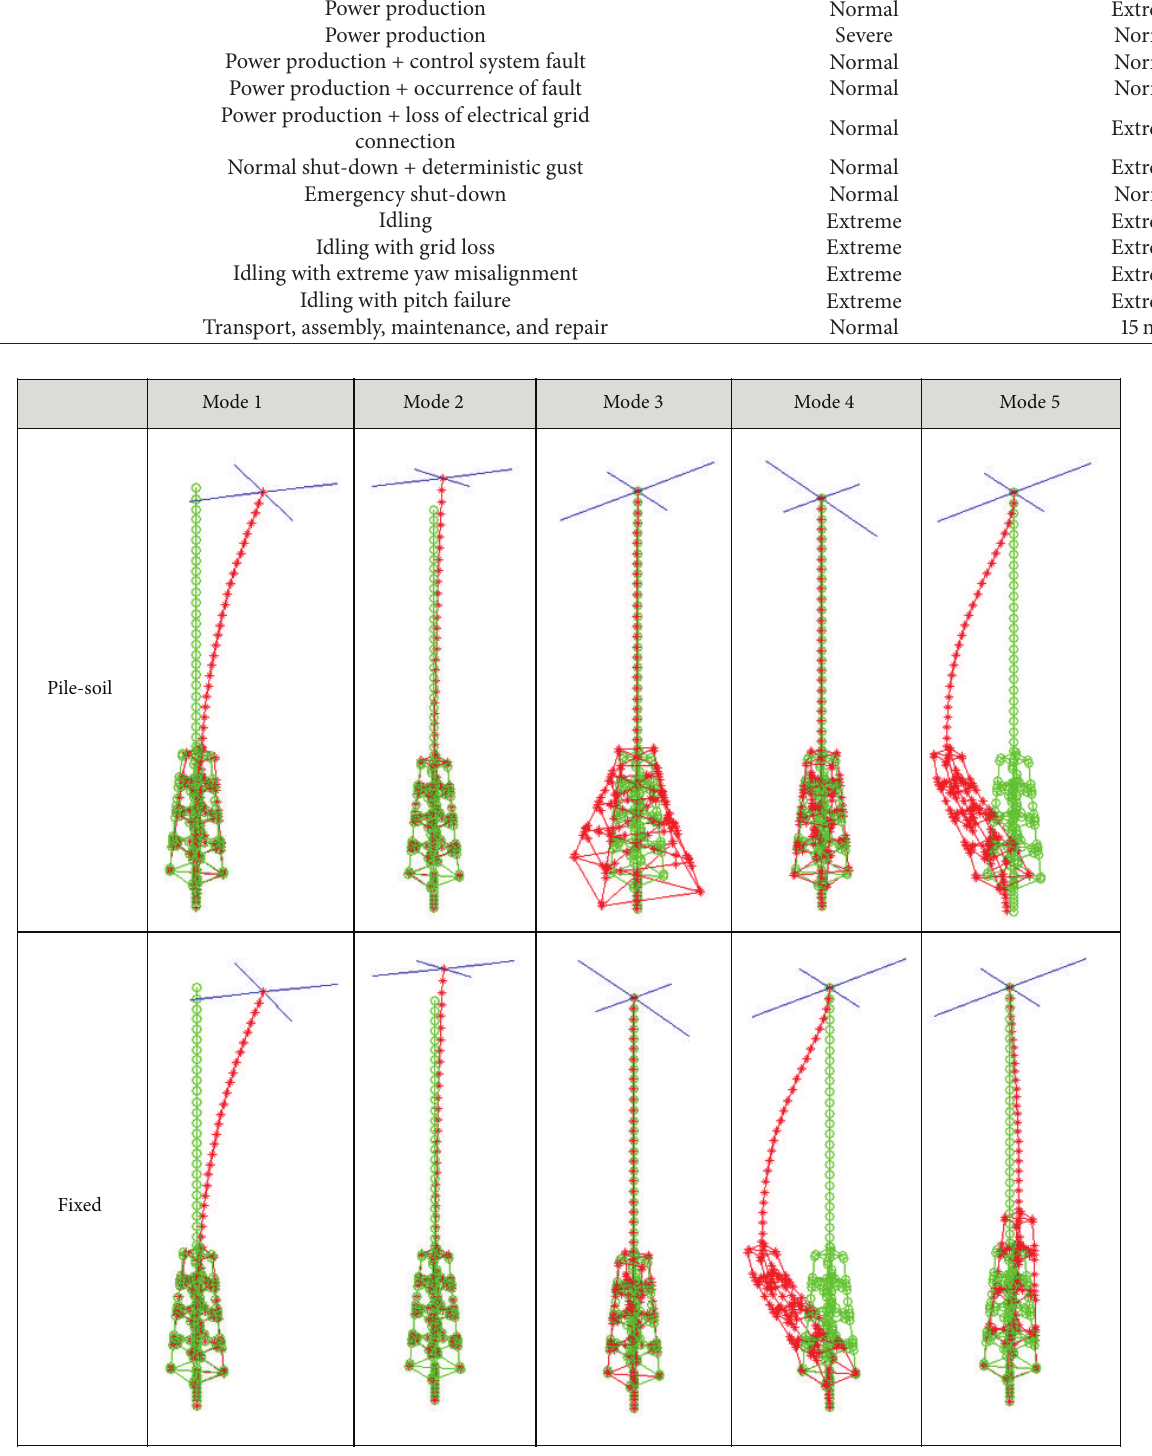
Figure 2: Comparison of mode shapes of hybrid